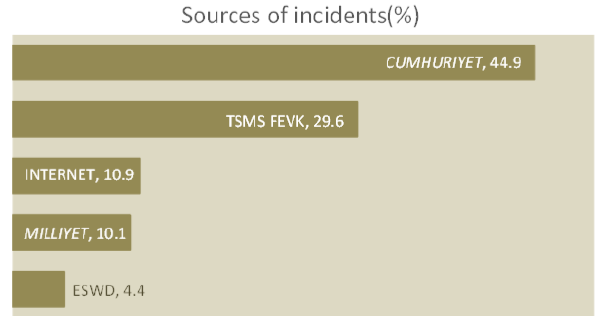
Table 1. Average fatality rates per million people per year for some countries.